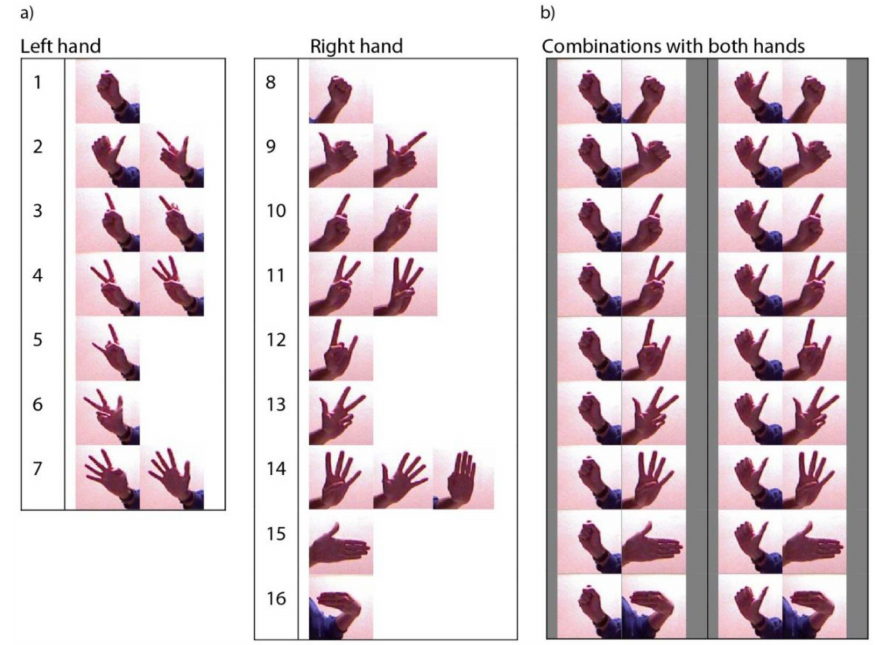
Figure 20. Full set of gestures that the recognition descriptor is able to identify correctly and are considered for handling the robot. ( a ) With just one, left or right hand; ( b ) Sequence of two gestures with both hands.